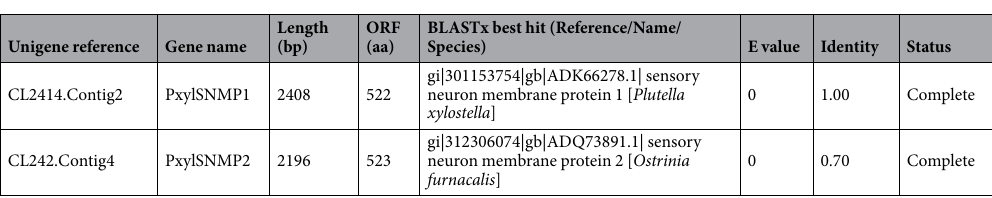
Table 6. Candidate sensory neuron membrane protein